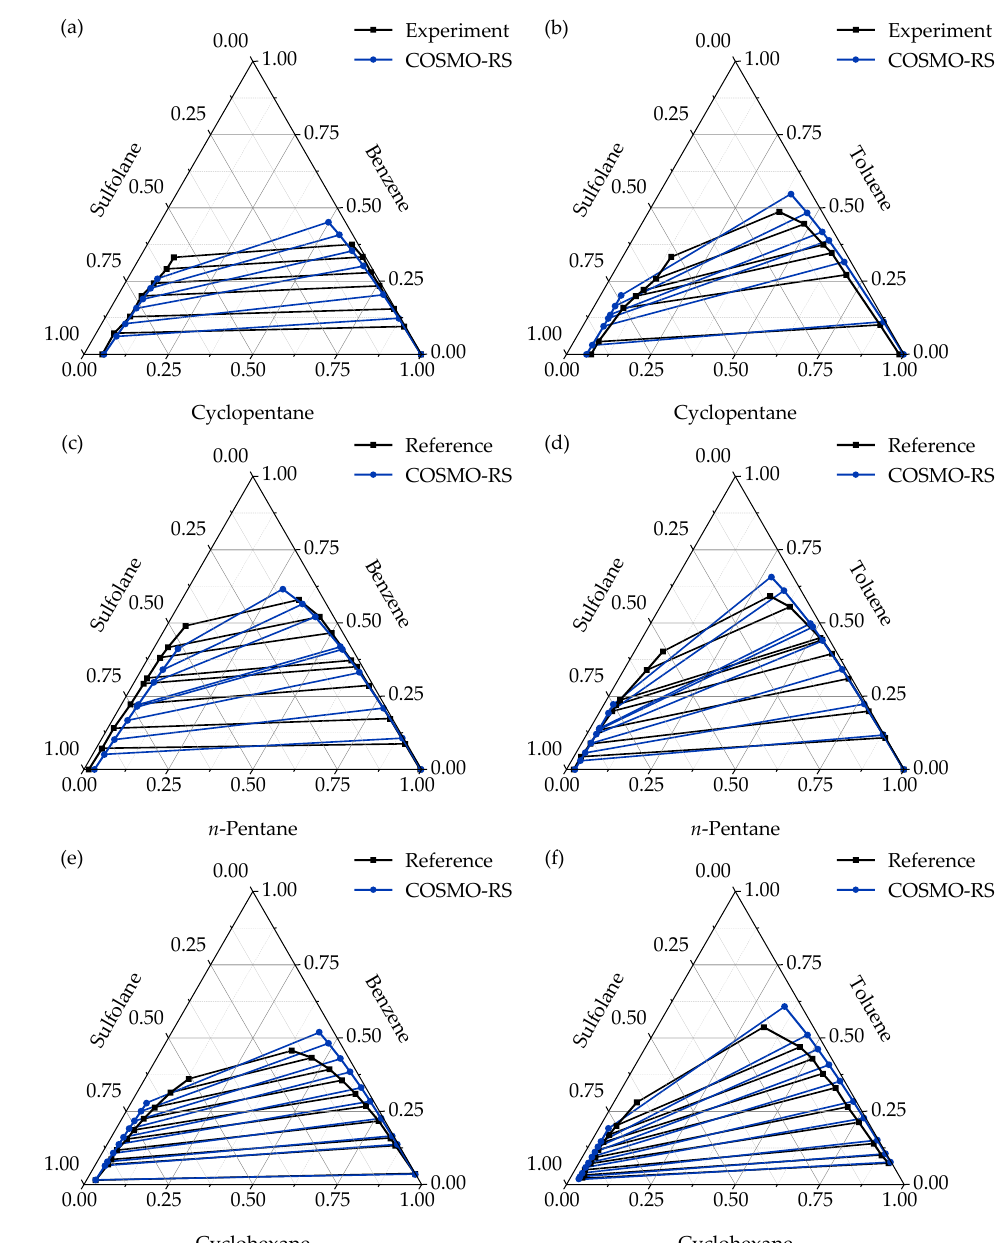
Figure 1. Ternary LLE data for ( a ) cyclopentane (1)–benzene (2)–sulfolane (3), ( b ) cyclopentane (1)–toluene (2)–sulfolane (3) at 313.15 K and 101.3 kPa, and ternary LLE data for ( c ) n -pentane (1)–benzene (2)–sulfolane (3) systems, ( d ) n -pentane (1)–toluene (2)–sulfolane (3), ( e ) cyclohexane (1)–benzene (2)–sulfolane (3), and ( f ) cyclohexane (1)–toluene (2)–sulfolane (3) at 298.15 K and 101.3 kPa. ( ■ ) Experimental or reference [29,30] data; (●) calculated data using the COSMO-RS model. (The method of Roozeboom was used to depict the composition of the ternary phase diagram).